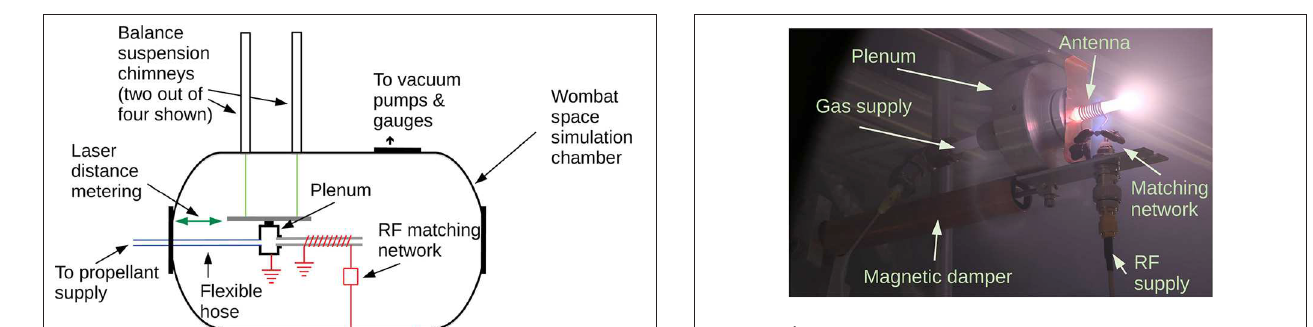
FIGURE 4 | Photo of the inductive PR mounted on the thrust balance and shown operating inside the Wombat chamber. The magnetic damper consisting of a copper tube attached to the chamber and a set of permanent magnets attached to the thruster can be seen below the thruster, to the left hand side. The RF matching network can also be seen, in this instance consisting of fixed value silver mica capacitors